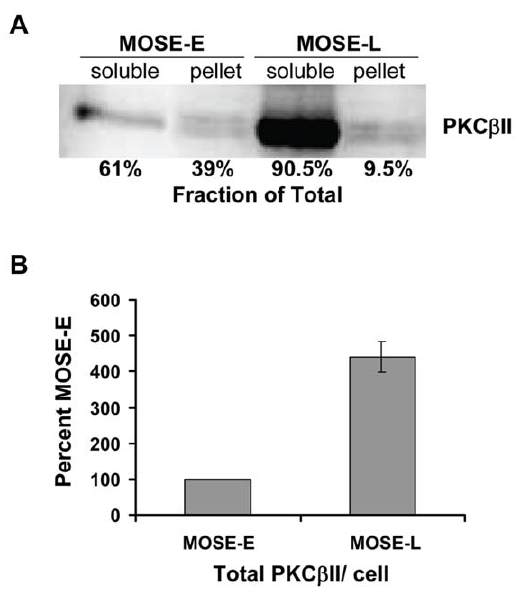
Figure 6. PKC b II protein levels and interactions with cytoskel- eton. Equal amounts of protein from MOSE-E and MOSE-L was fractionated into 1% triton X-100 soluble and non-soluble (pellet) portions and analyzed by western blot analysis ( A ). Protein levels are the mean of three measurements expressed as percent of the total PKC b II protein with standard deviations # 1.5% for all samples, normalized by cell number. ( B ) Total protein levels (soluble + pellet) (mean of three measurements) are expressed as percent of MOSE-E levels. * p , 0.001.